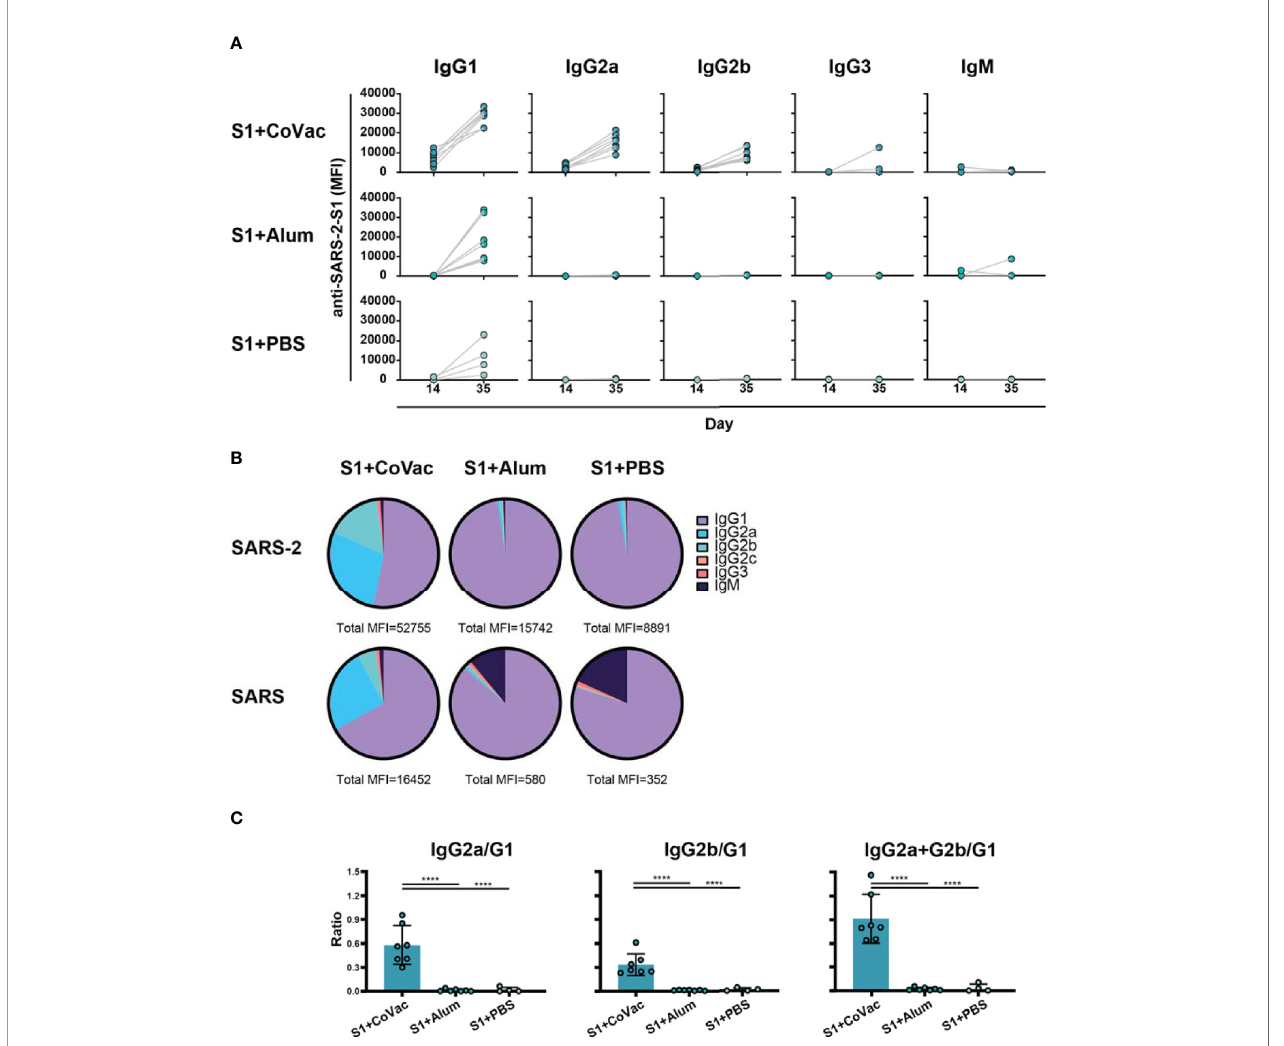
FIGURE 3 | Adjuvant effects on immunoglobulin subclass diversity. (A) IgG subclasses reacting with SARS-2 S1 antigen between day 14 and day 35 plotted on a linear scale. (B) Relative abundance of Immunoglobulin isotypes and IgG subclasses reacting to SARS-2 and SARS antigens determined by subtracting the speci fi ed subclass cut-off values from the geometric mean of each group. The total median fl uorescence intensity (MFI) from which the subclasses are a fraction of is listed below each pie-chart. (C) Ratios of subclasses. The normalized MFI values of each subclass per mouse were plotted as ratios using mean and SD. Statistics by standard one-way ANOVA. ****p-value < 0.0001.